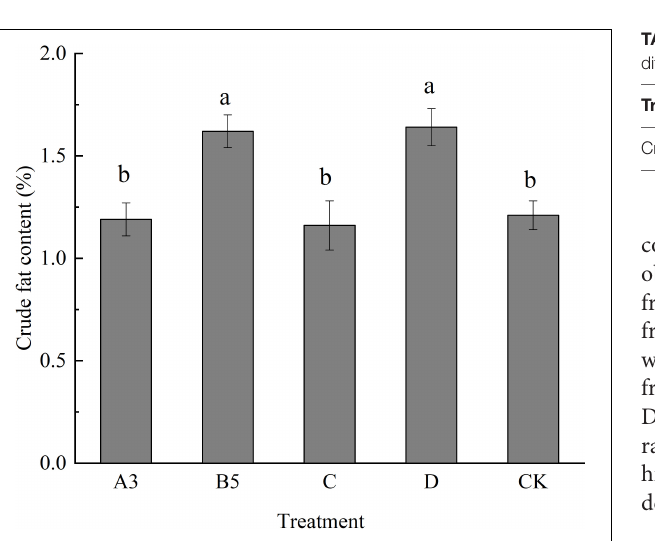
FIGURE 5 | Crude fat content of fruiting bodies of each treatment. Different letters in the figure indicate significant differences ( P < 0.05).